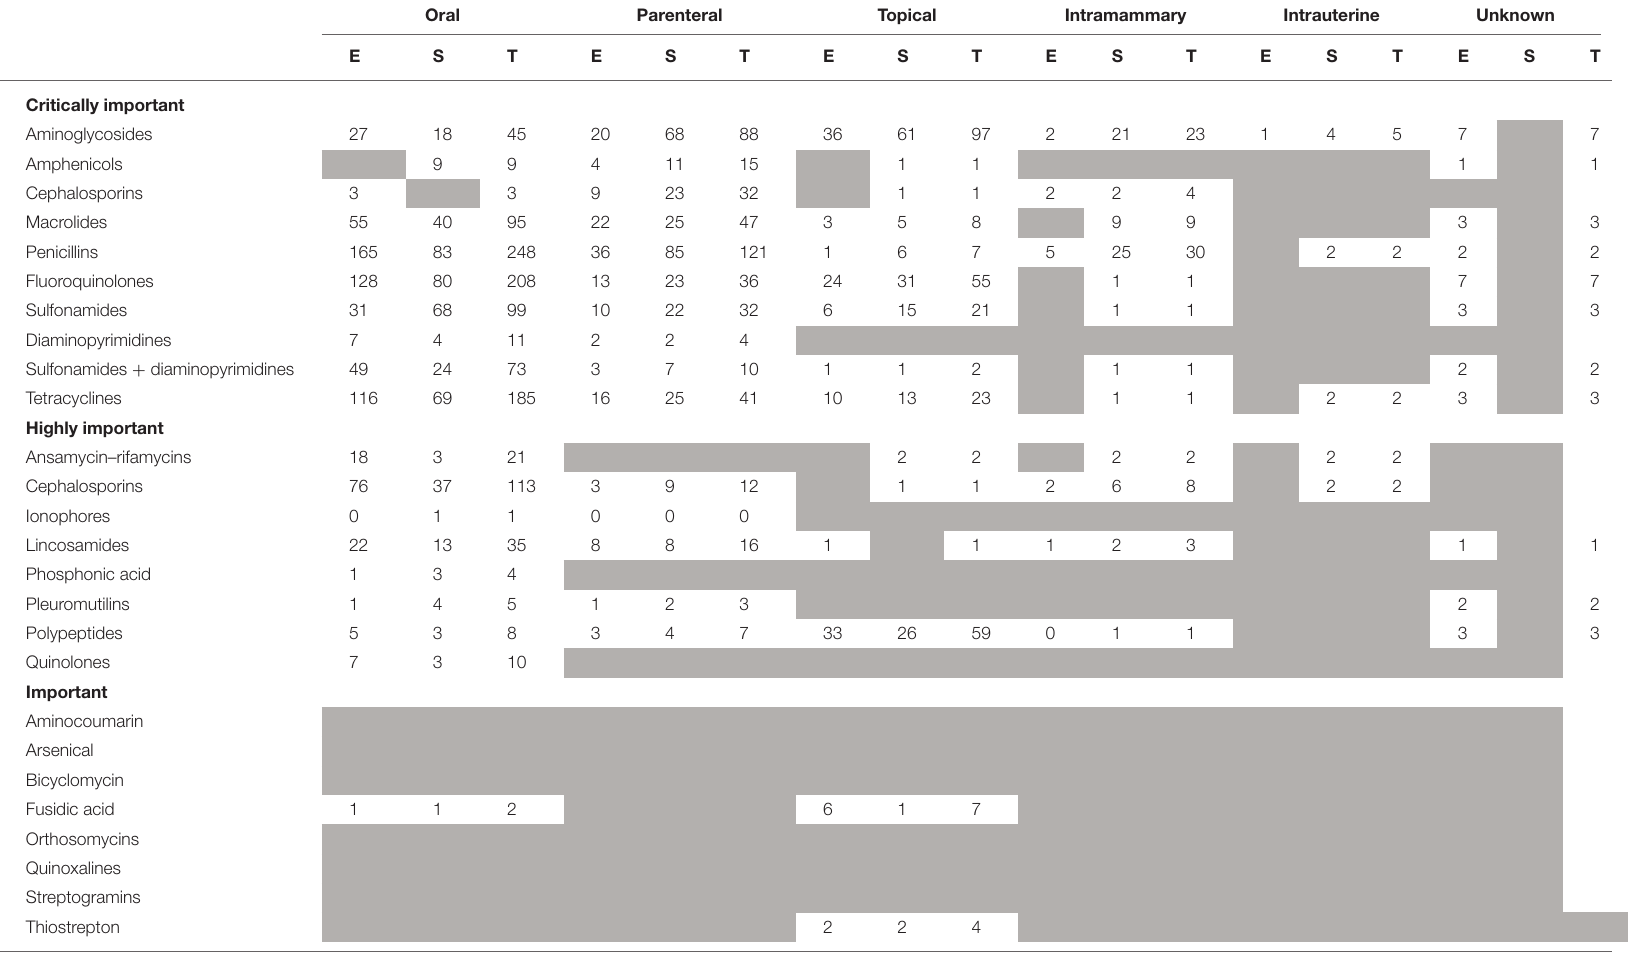
The numerical value corresponds to the sum of the web pages where each of the individual antibiotics included in the family is sold. The names of the individual compounds included in each family are detailed in Table 1 . The number of websites selling each individual antibiotic according to the administration route are included in Supplementary Table S2 . Cells shaded in gray indicate zero offers. E, search in English; S, search in Spanish; T,